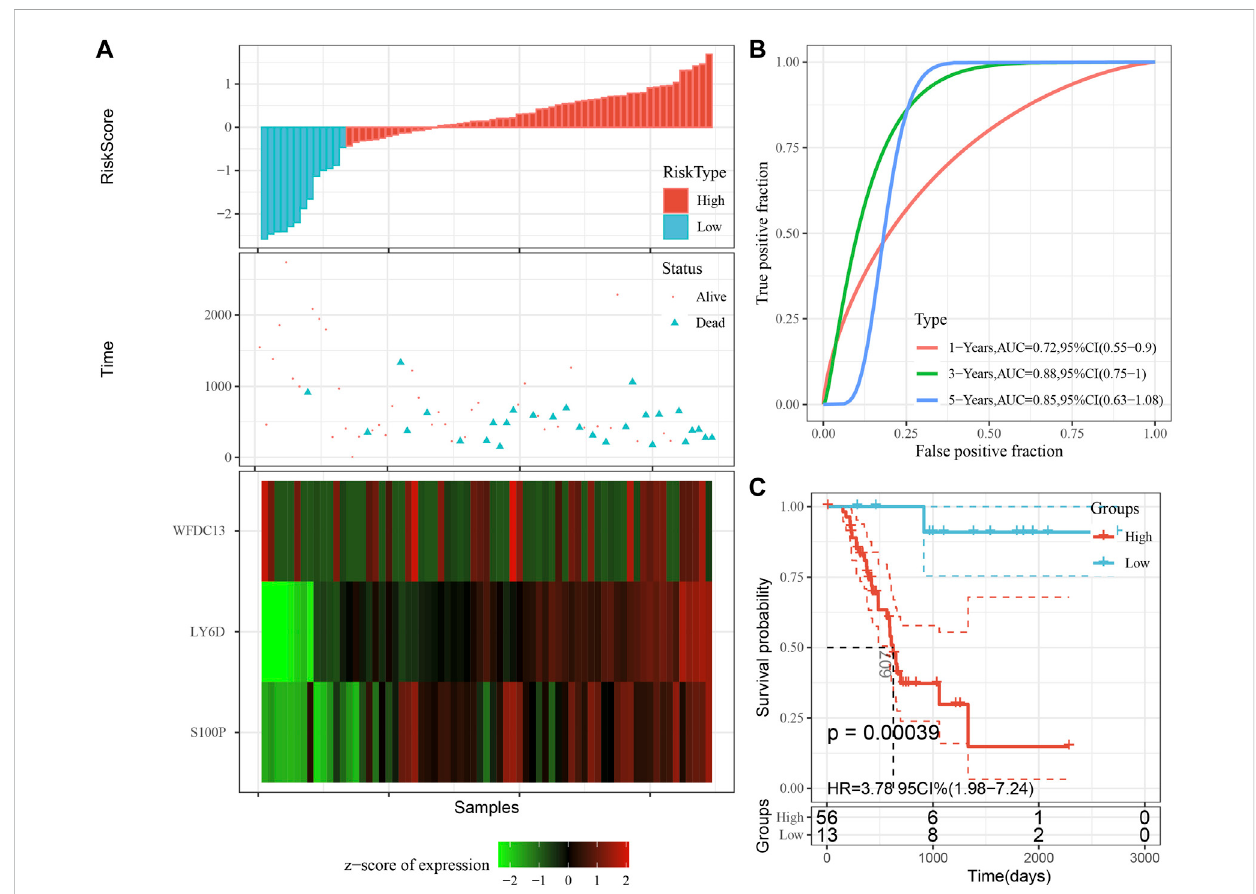
FIGURE 10 Validation of prognostic gene signatures in KRAS wild-type PAAD samples. (A) Risk score, survival time and survival status and expression of the 3 genes in KRAS wild-type samples; (B) ROC curves and AUC of the 3-gene signature classi fi cation; (C) Distribution of KM survival curves of 3-gene signature in TCGA KRAS wild-type